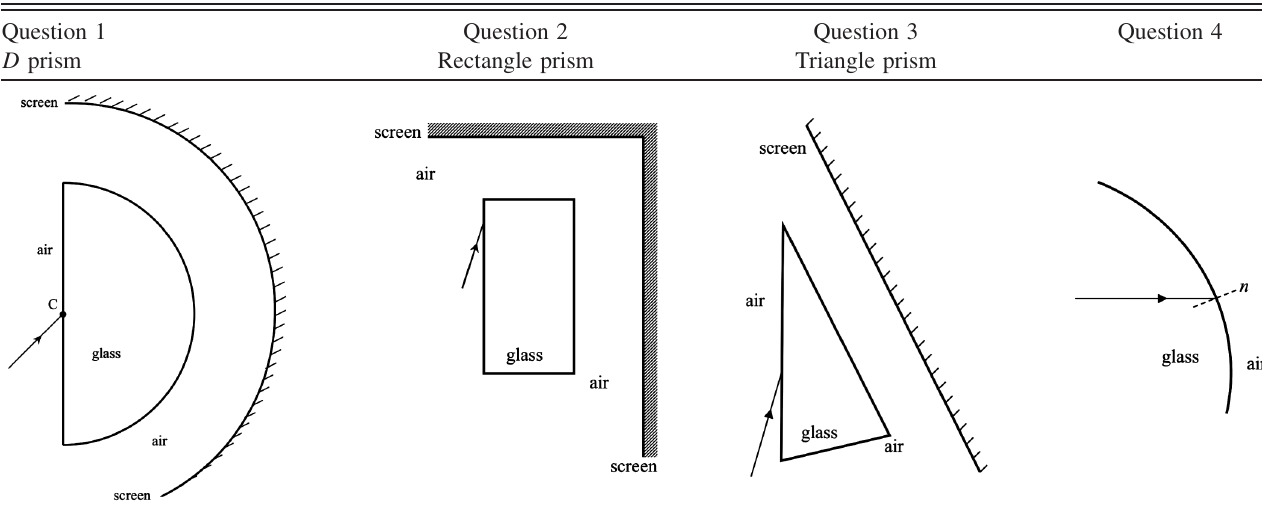
SPECIFICITY, TRANSFER, AND THE . . TABLE I. The four assessment questions for experiment 1. The order of presentation of questions 2 and 3 was counterbalanced. Participants were not allowed to return to a previous question once they had completed it and gone on to the next question. Question 1